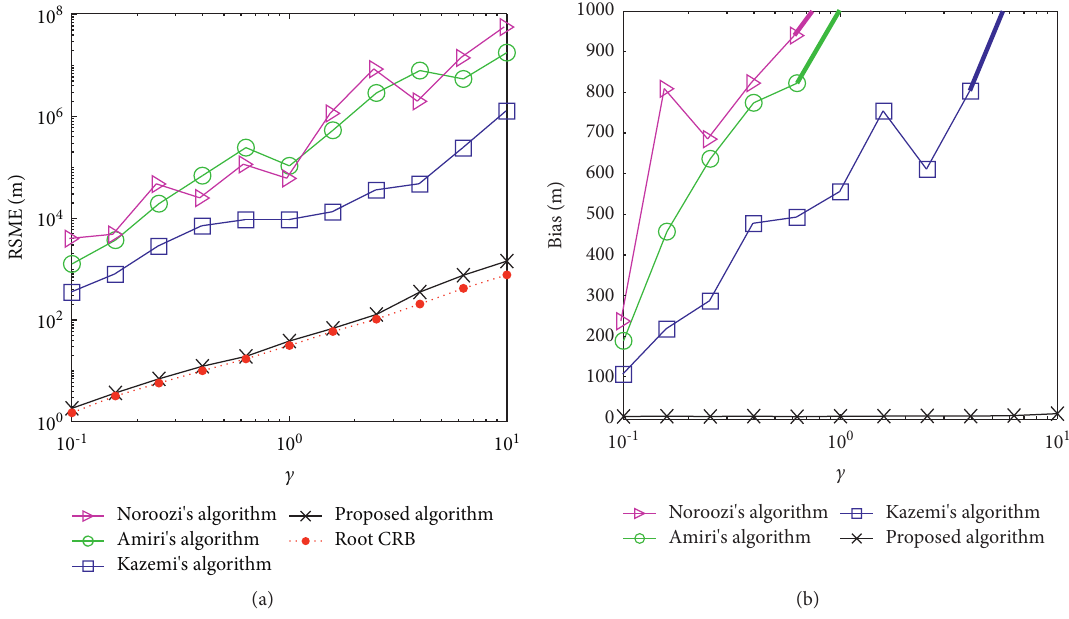
Figure 4: Localization (a) RMSE and (b) bias versus noise dispersion for different